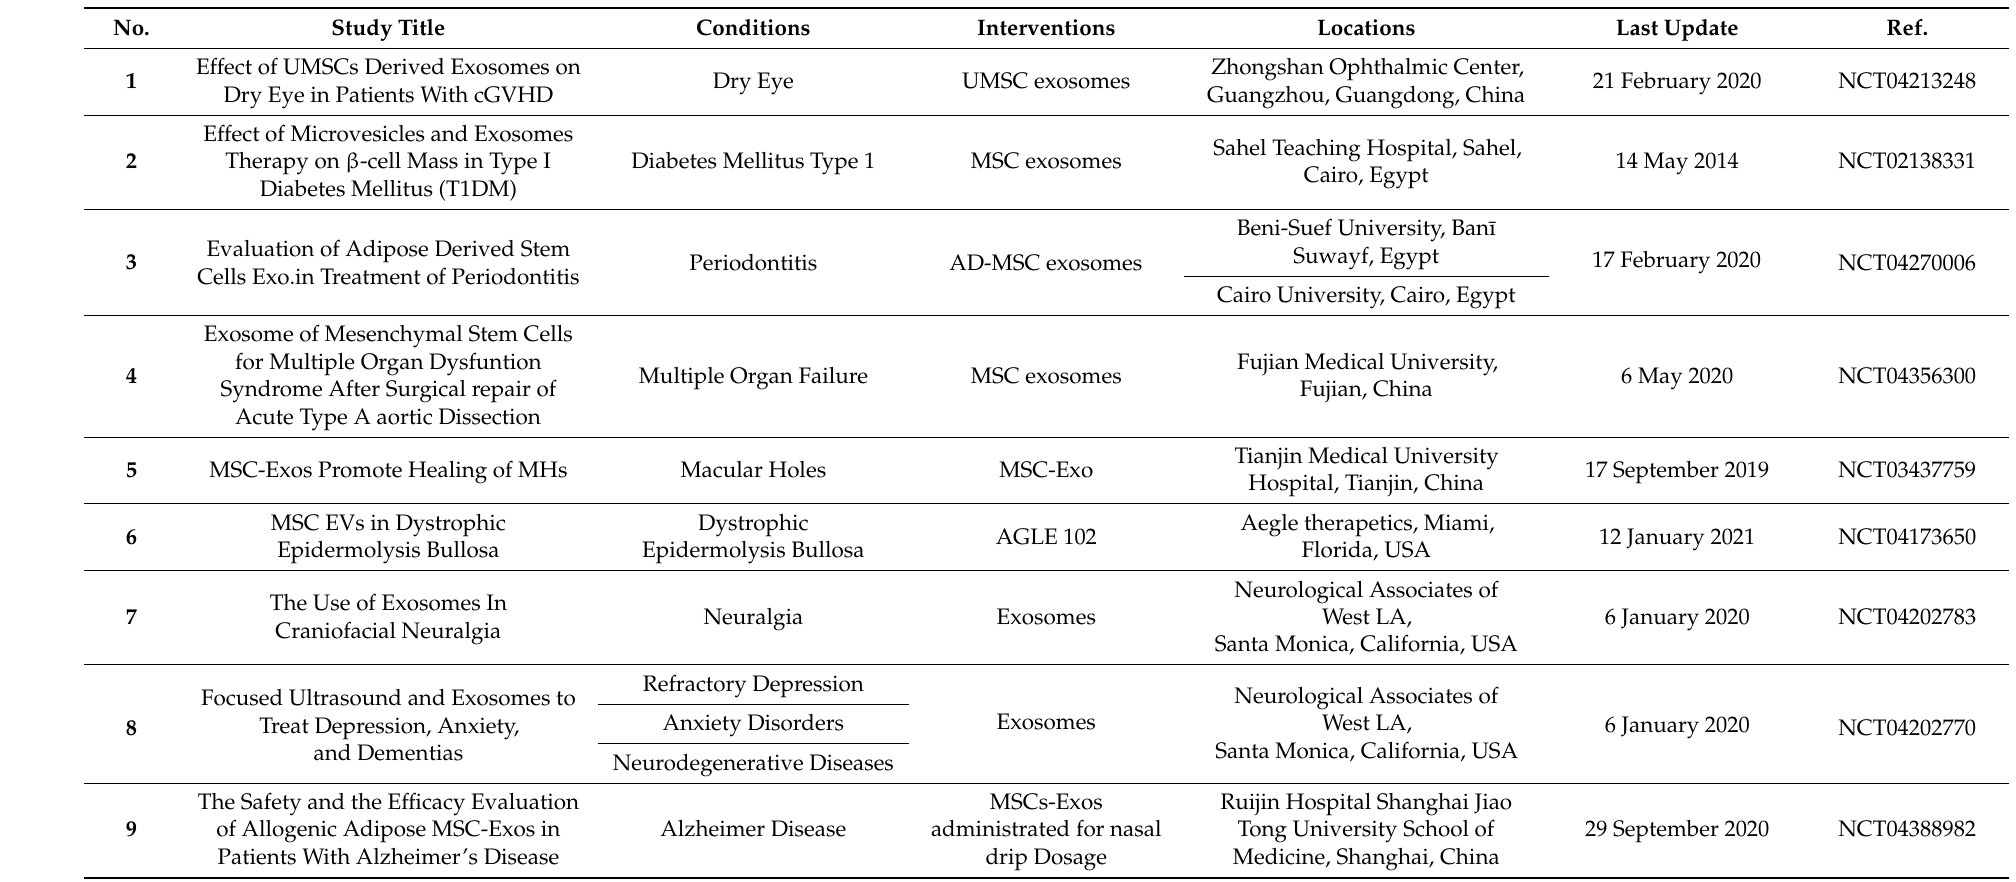
Table 1. Ongoing clinical trials using MSC exosomes